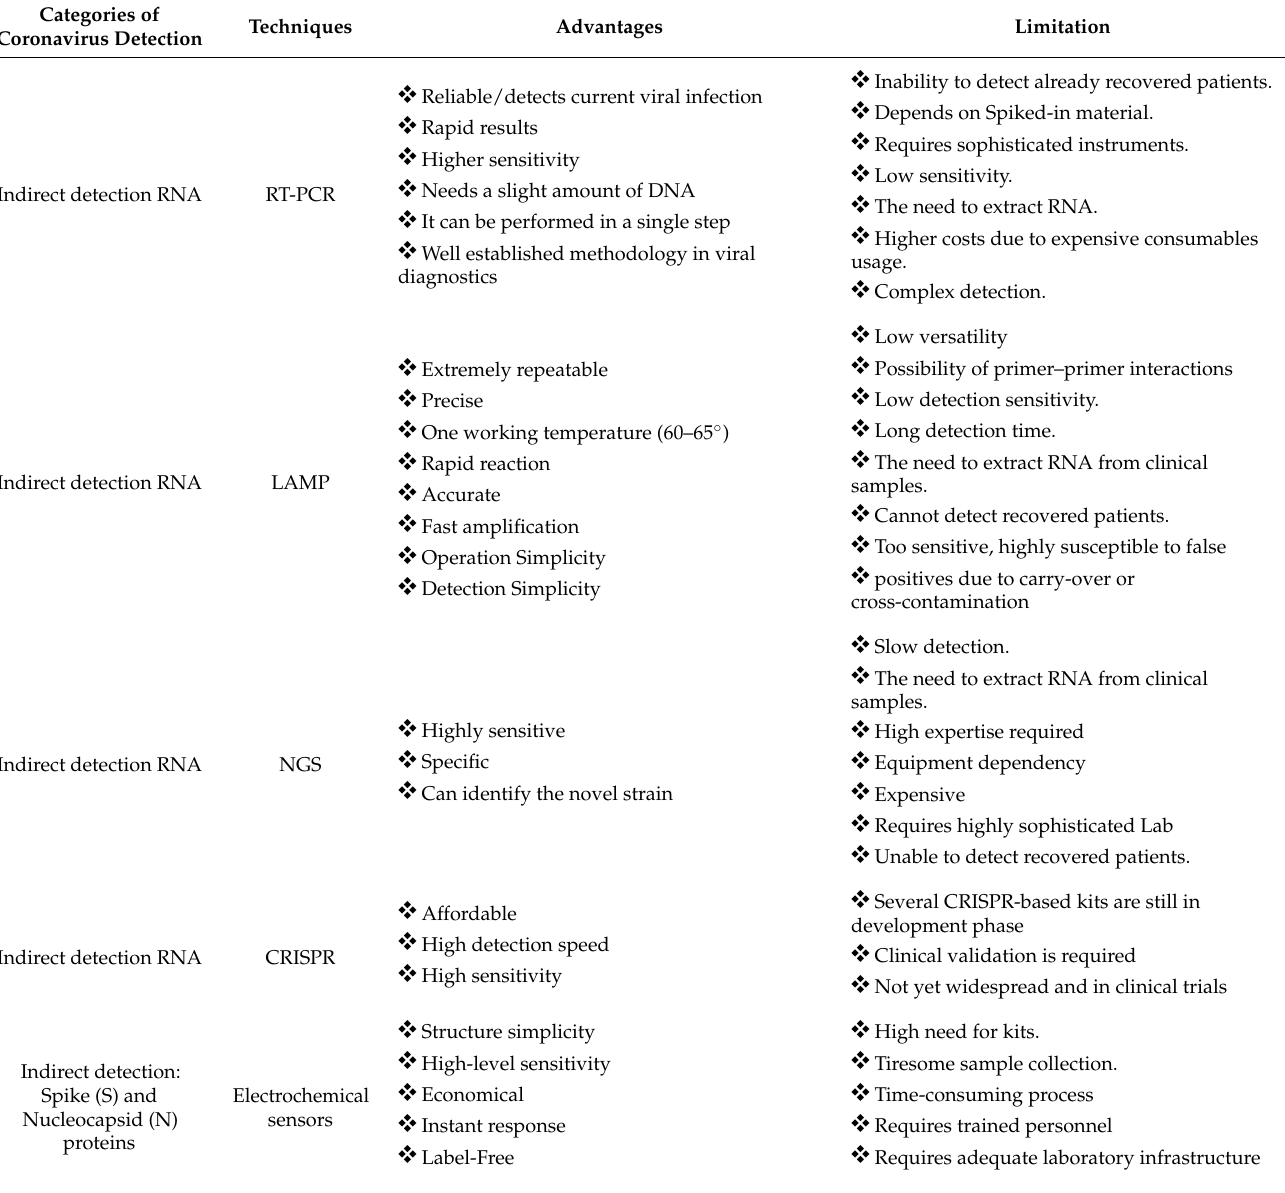
Table 5. COVID-19 detection techniques advantages and limitations comparison.